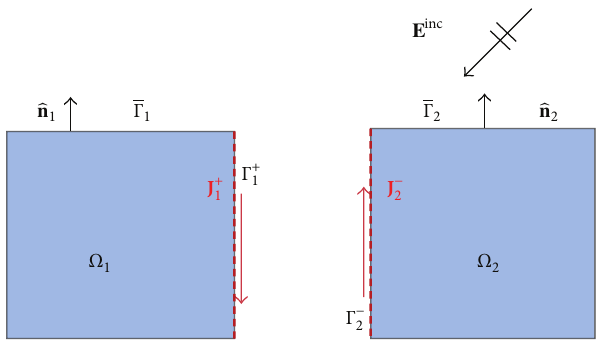
Figure 2: The notation of the decomposition of the original PEC object.